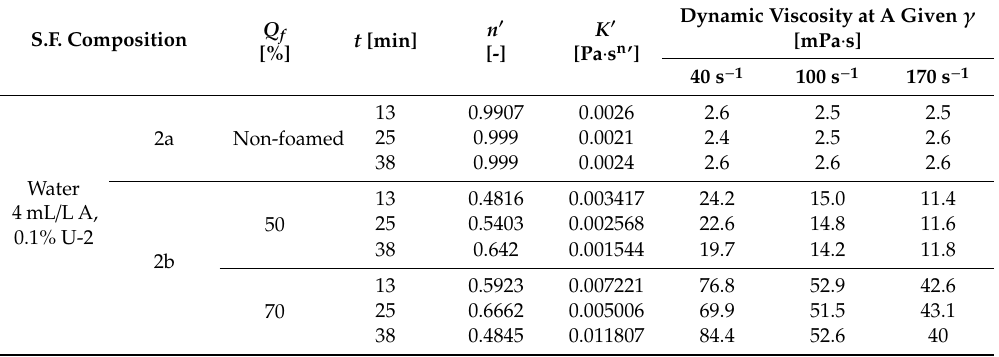
Table 2. Rheological parameters of fluids energized with N 2 with the application of U-2 nanoadditive, foam quality of 50% and